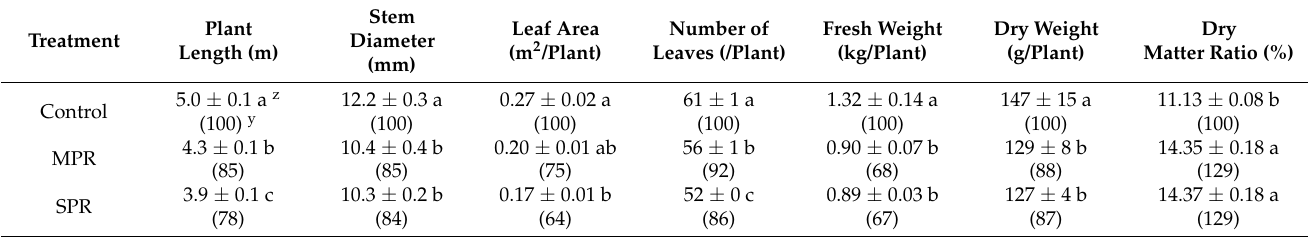
Effects of water stress on tomato growth measured at 92 days after the start of treatments (DAT).